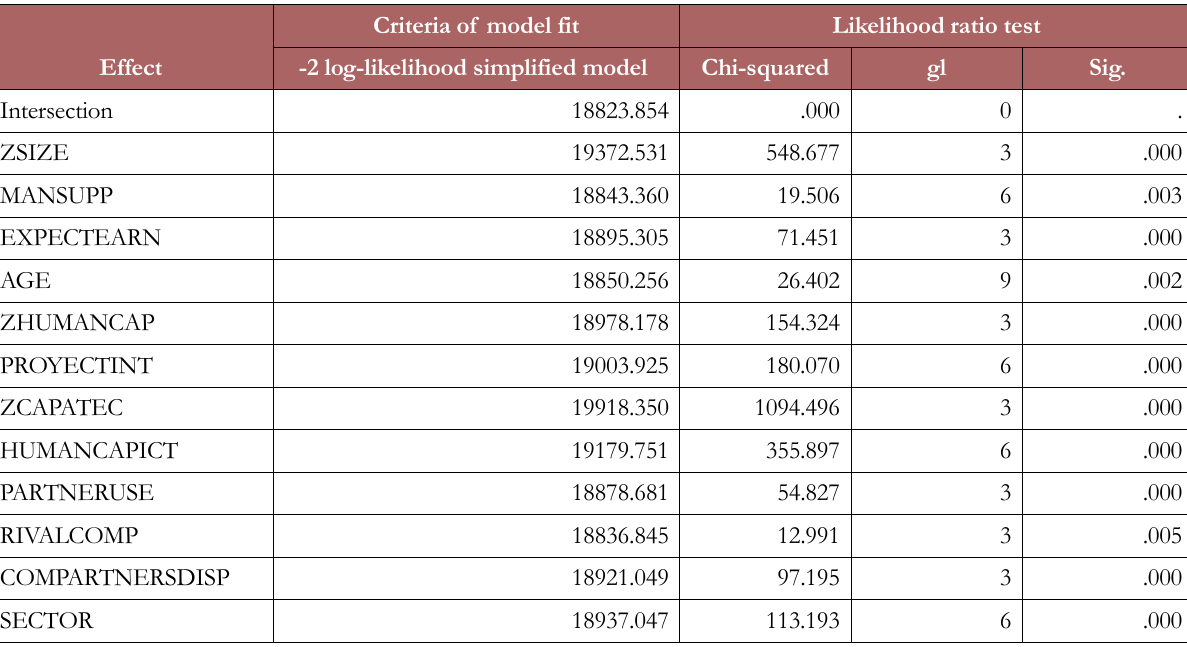
Table 6. Likelihood ratio test of model on e-Business